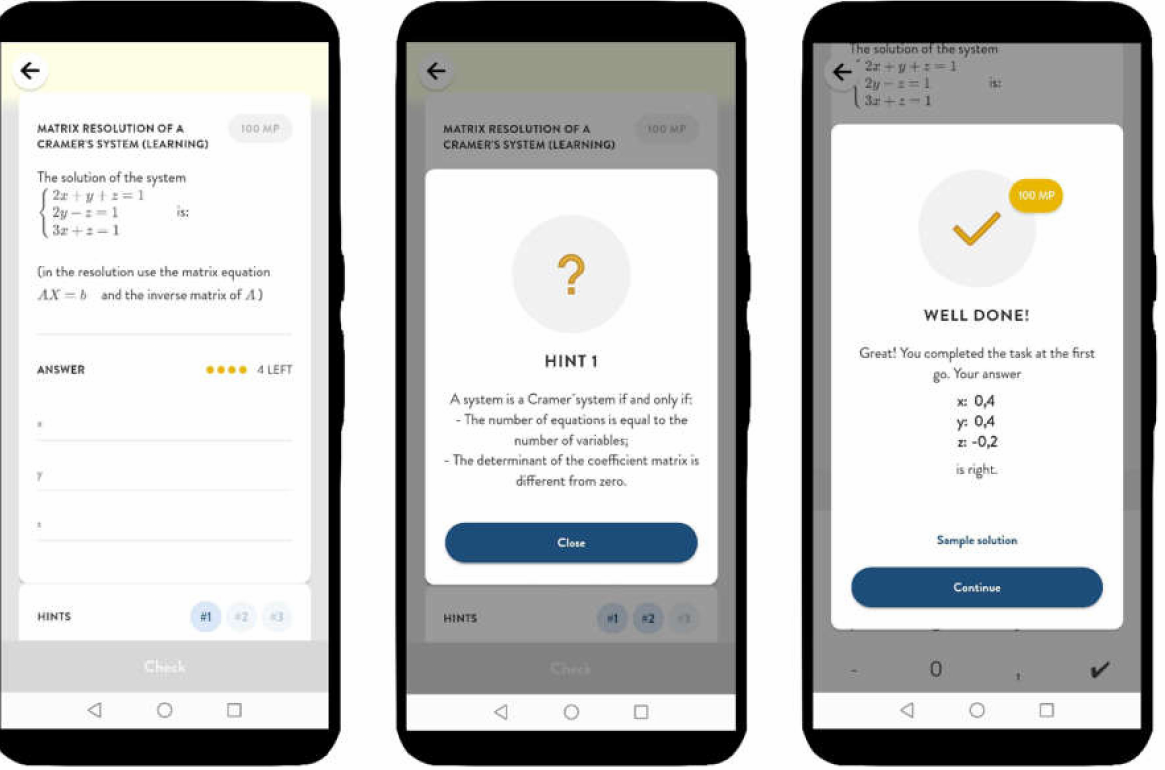
Figure 4. Prototypical task view in the ASYMPTOTE app: an exemplary task with the title, instruction, and answer form is shown; display of the first of three available hints; the immediate answer validation including points and the possibility of invoking a sample solution (from left to right